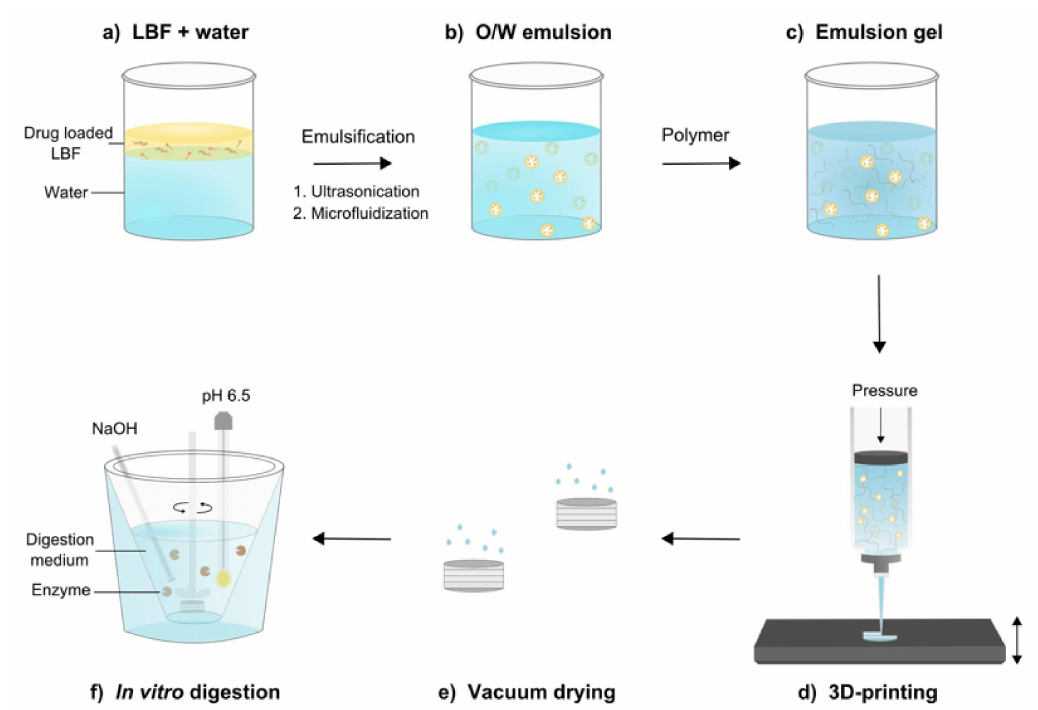
Figure 6. Schematics illustrating the preparation of printable emulsion gels, 3D printing by semi-solid extrusion (SSE), and in vitro digestion of 3D-printed tablets. ( a ) Drug-loaded lipid-based formulation (LBF) was added to water, followed by ( b ) a two-step emulsification process. ( c ) Polymers were added to emulsified LBFs to generate printable emulsion gels. ( d ) The emulsion gels were 3D-printed by SSE into tablets, and ( e ) vacuum-dried. ( f ) 3D-printed tablets were digested in an in vitro lipolysis set-up to quantify the release of free fatty acids (FAs). Figures reproduced with permission from